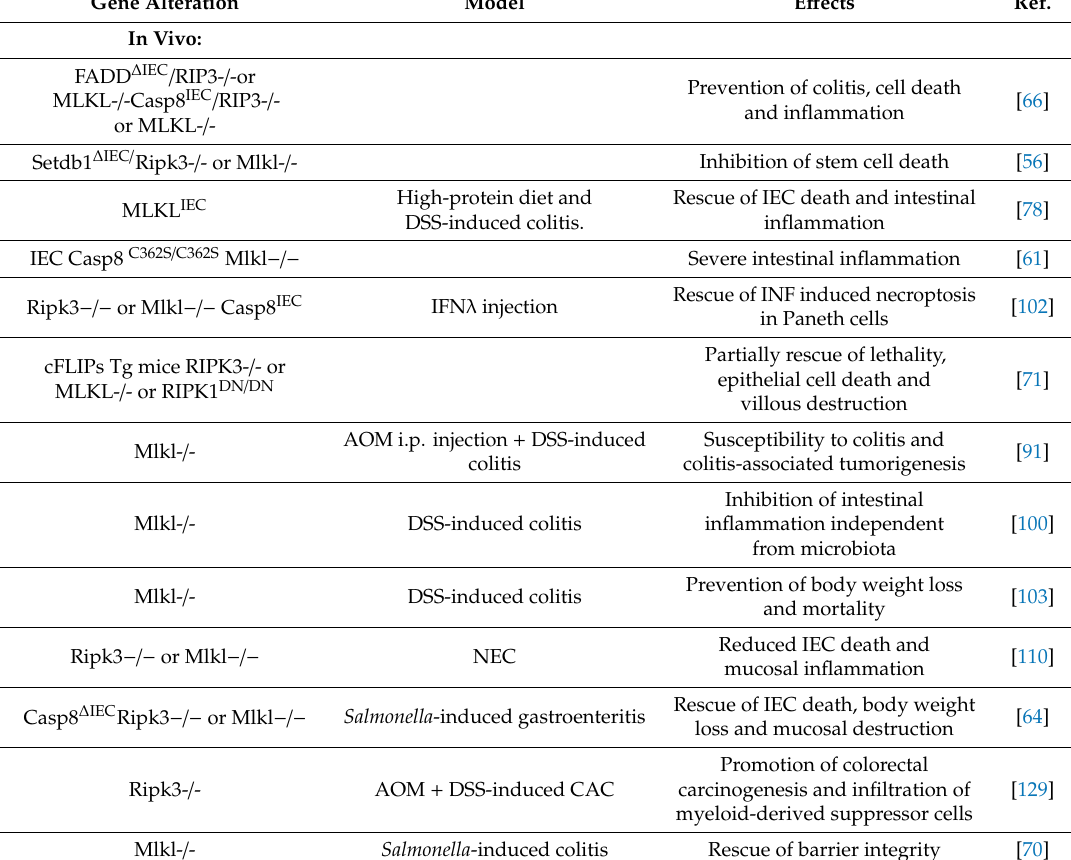
Table 2. In vivo and ex vivo studies reporting necroptotic genes alterations. IEC, intestinal epithelial cells; DSS, dextran sulfate sodium, IFN, interferon; AOM, azoxymethane; i.p., intraperitoneal; NEC, necrotizing enterocolitis; CAC, colitis-associated cancer; SMAC, second